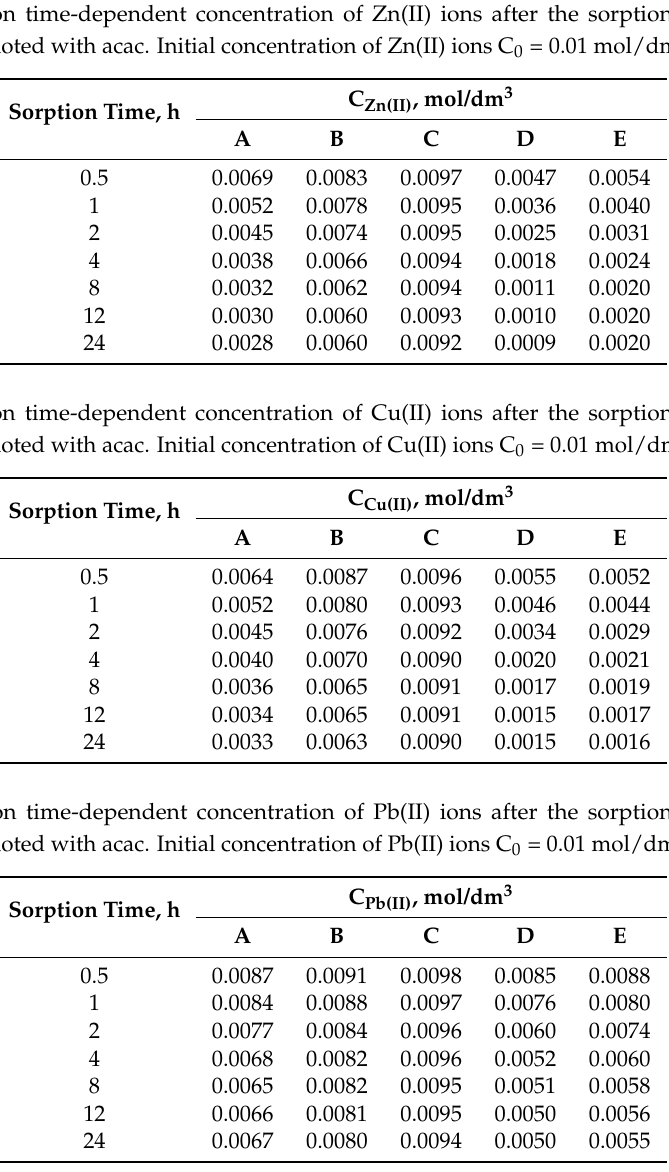
Table 3. Sorption time-dependent concentration of Zn(II) ions after the sorption on PVC-based